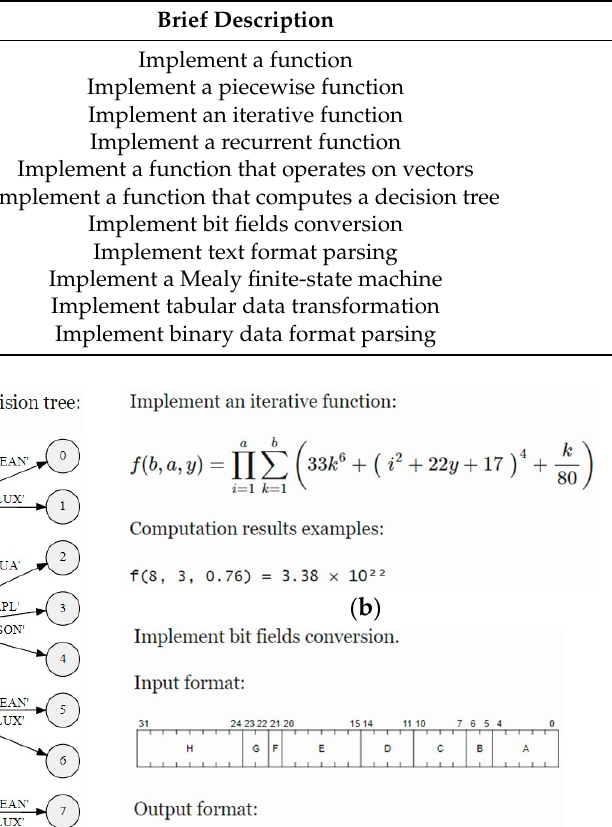
Table 1. Brief descriptions of programming exercise types available in DTA.